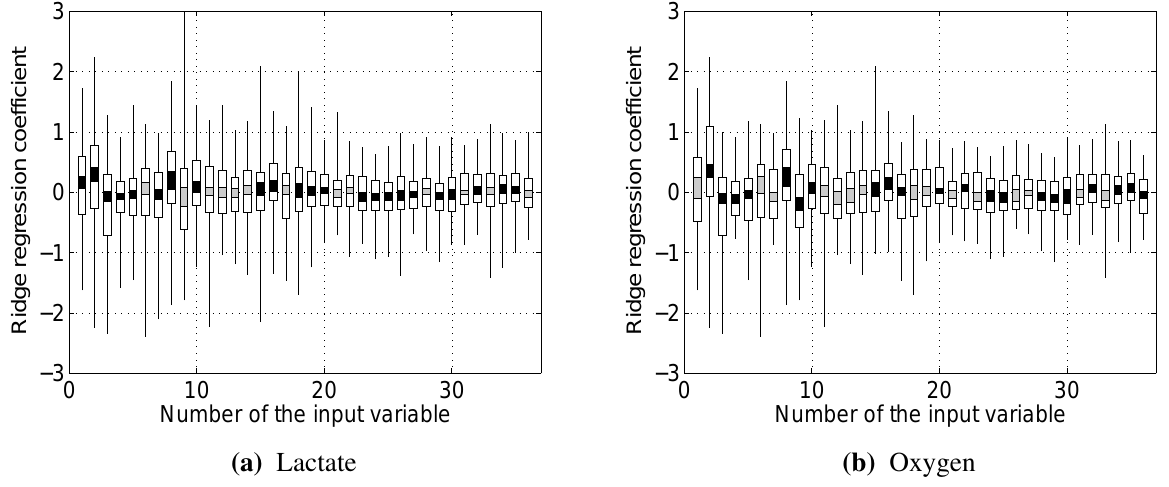
Figure 9. The distribution of input variable weights in linear regression models over all subject-specific datasets. Each segment of a bar represents an interval of 0.2 quantiles. Black bars represent input variables, for which the mean weight is significantly ( p < 0 . 05 ) different from zero. Variables and their numbers were defined in Section 2.5.